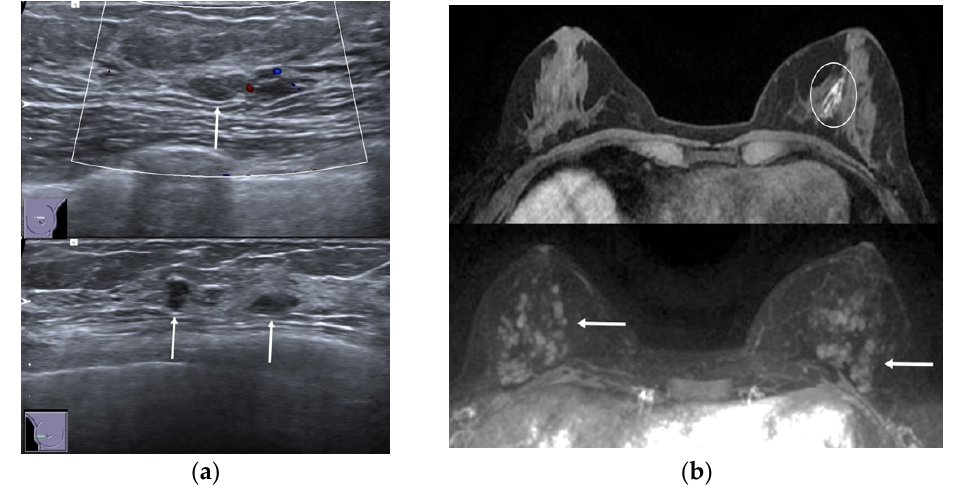
Figure 5. A 36-year-old woman with left bloody nipple discharge. ( a ) Ultrasound demonstrated bilateral multiple hypoechoic masses with circumscribed margins with ductal relation (arrows). ( b ) MRI showed dilated ducts with high T1 signal on pre-contrast sequences (circle) and multiple enhancing masses related with ductal contrast enhancement on post-contrast images (arrows).